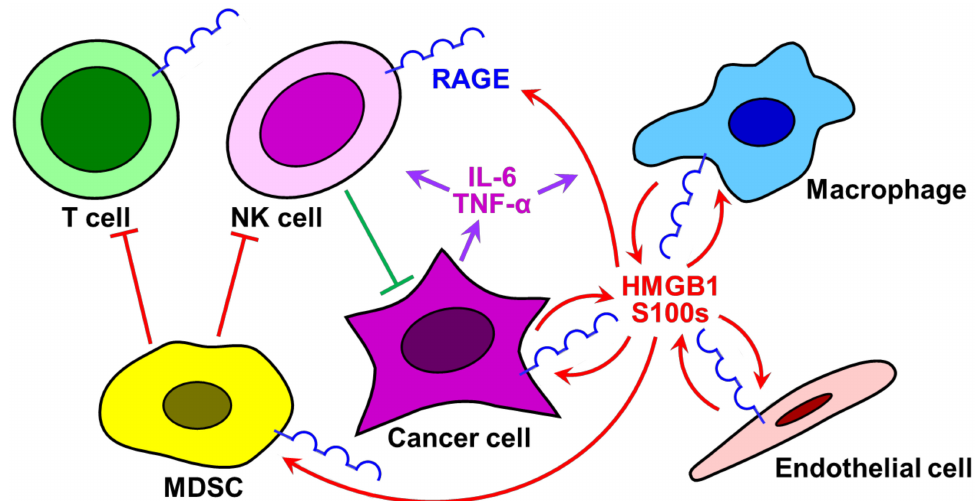
Figure 1. Schematic illustrating the functional role of receptor for the advanced glycation endo-products (RAGE)-RAGE ligand signaling in linking inflammation to carcinogenesis. In a microenvironment of tumor, where cancer cells up-regulate NF- κ B expression by hypoxia-inducible factor-1 α (HIF-1 α ), an inflammatory tumor microenvironment (TME) is established by the secretion of pro-inflammatory cytokines, such as IL-6 and TNF- α , and thereby the release of RAGE ligands, such as HMGB1 and S100s, from recruited macrophages and endothelial cells. The RAGE-RAGE ligand signaling activates inflammation in feedforward loops, resulting in the recruitment of NK and T cells, and further myeloid-derived suppressor cells (MDSCs). MDSCs suppress NK and T cells, leading to T cell tolerance and impaired anti-cancer